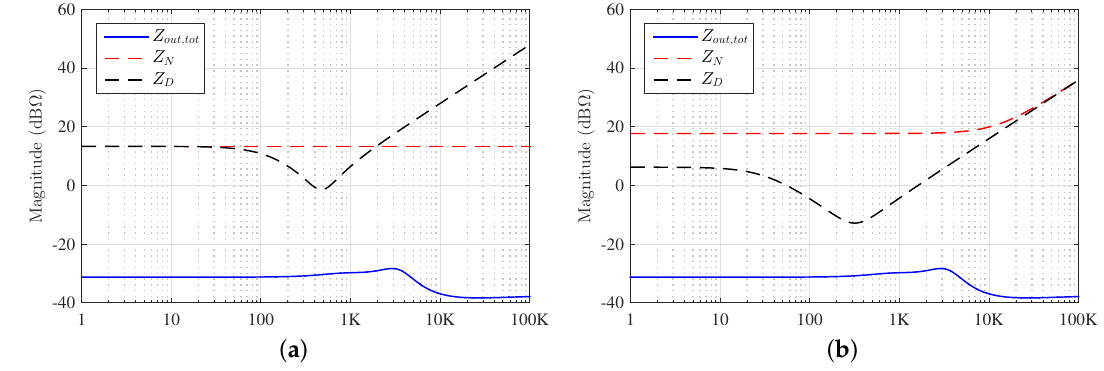
Figure 18. Comparison between (cid:107) Z out , tot (cid:107) and (cid:107) Z N (cid:107) , (cid:107) Z D (cid:107) when ( a ) the load converter or ( b ) the PV converter is analyzed.